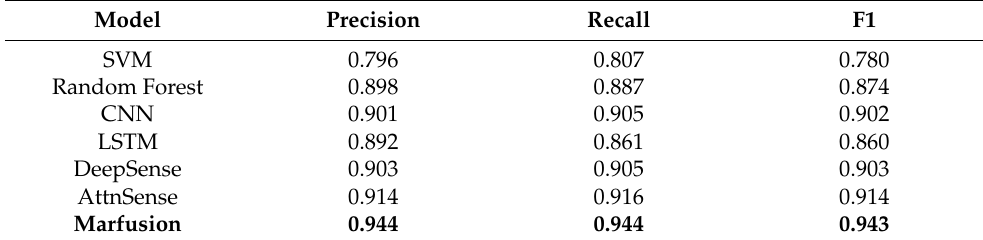
Table 5. The evaluation indicators of each model obtained on the test set.